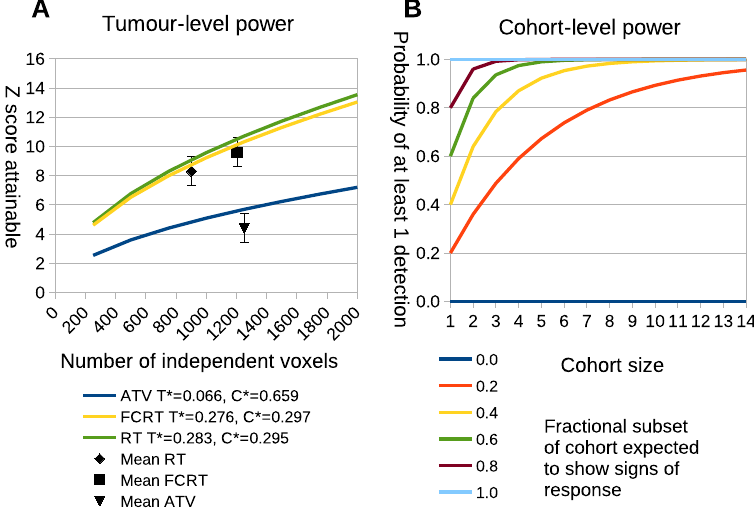
Figure 9. ( A ) The x-axis is the number of independently measured voxels within a tumor. The y-axis is the statistical power that is predicted to be achieved in standard deviations away from the null- hypothesis of there being no treatment effects. Each curve makes use of ambiguity terms computed from the three different treatment groups. The black points show where the real data lies, with error bars based upon the spread of Z scores seen within the respective cohorts. ( B ) The probability of observing at least one positive detection within a cohort when only a subset of tumors respond. The x-axis is the number of tumors within a cohort. The y-axis is the probability of at least one detection. Each curve represents a different level of fractional response at a cohort-level, i.e., the fraction of tumors that are likely to give a true